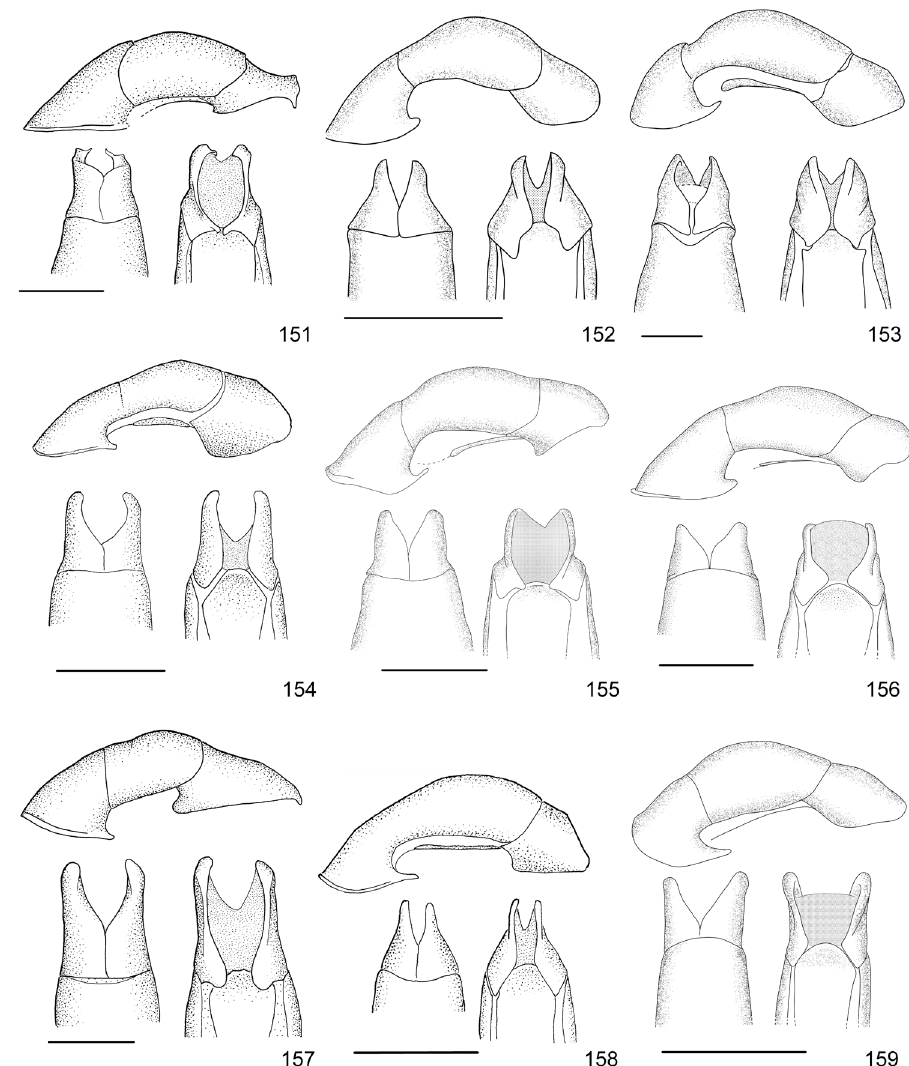
Figures 151–159. Shape of aedeagus, lateral view (top), dorsal view (bottom left), ventral view (bottom right). 151 Anomala longisacculata (La Montura, San José, CEUA) 152 A. ludoviciana (Finca Jenny, Gua- nacaste, MNCR) 153 A. megalia (Manzanillo, Limón, MNCR) 154 A. megaparamera (Estación Cuatro Esquinas, Limón, MNCR) 155 A. mersa (Sector Palo Verde, Guanacaste, MNCR) 156 A. mesosticta (Los Arbolitos, heredia, MNCR) 157 A. m-fuscum (Río Grande de Orosí, Cartago, MNCR) 158 A. moroni (Estación Palo Verde, Guanacaste, MNCR) 159 A. nigroflava (Río Rincon, Puntarenas, MNCR). Scale bars: 1 mm. Fig. 154 from Filippini et al. (2013), Fig. 159 from Filippini et al. (2014); Figs 155–156 from Filippini et al. (2015c); Figs 151, 157 from Filippini et al. (2015d); Fig. 158 from Filippini et al.